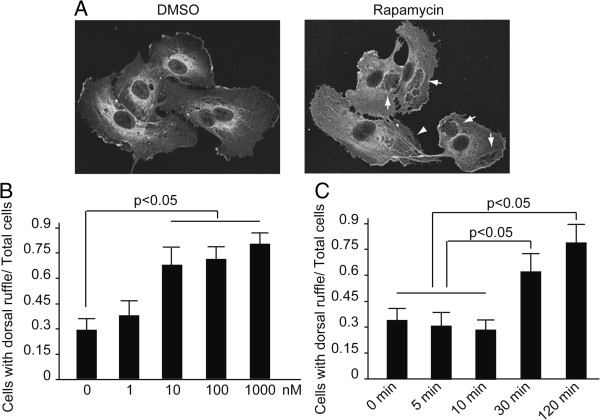
Rapamycin promoted membrane remodeling in HUVECs. (A) HUVECs were incubated with rapamycin (10 nM) for 30 minutes. Cells were fixed and detected by immunofluorescence with an anti-β-actin antibody. The representative images showed the formation of dorsal ruffle. (B) HUVECs were treated with the indicated concentration of rapamycin for 30 minutes. Cells were fixed and detected by immunofluorescence with an anti-β-actin antibody. The ratio of cells with dorsal ruffle to total cells was evaluated. Notice that rapamycin at the concentration of 10 to 1000 nM can lead to dramatically enhanced dorsal ruffle formation. Columns, means of three independent experiments; bars, SD. (C) HUVECs were incubated with rapamycin (10 nM) for the indicated time. Cells were fixed and detected by immunofluorescence with an anti-β-actin antibody. The ratio of cells with dorsal ruffle to total cells was evaluated. Means ± SD are given and were obtained from 3 independent experiments.